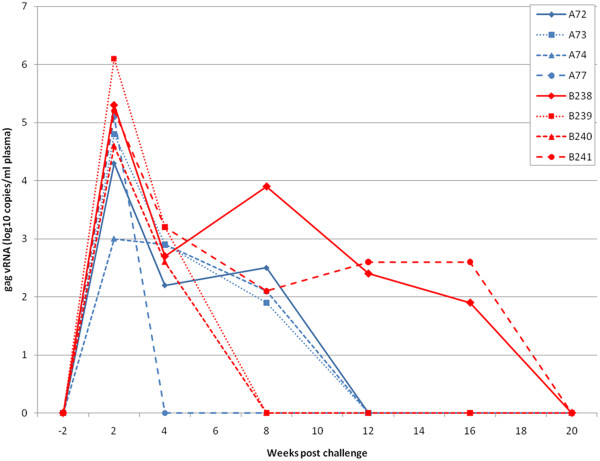
Viral RNA levels in vaccinated macaques (A72, A73, A74 and A78; group B: blue lines) and contemporaneous controls given ASO2Aadjuvant only (B238-241; group D: red lines) after challenge with 50MID50SHIVSF33and followed for twenty weeks.